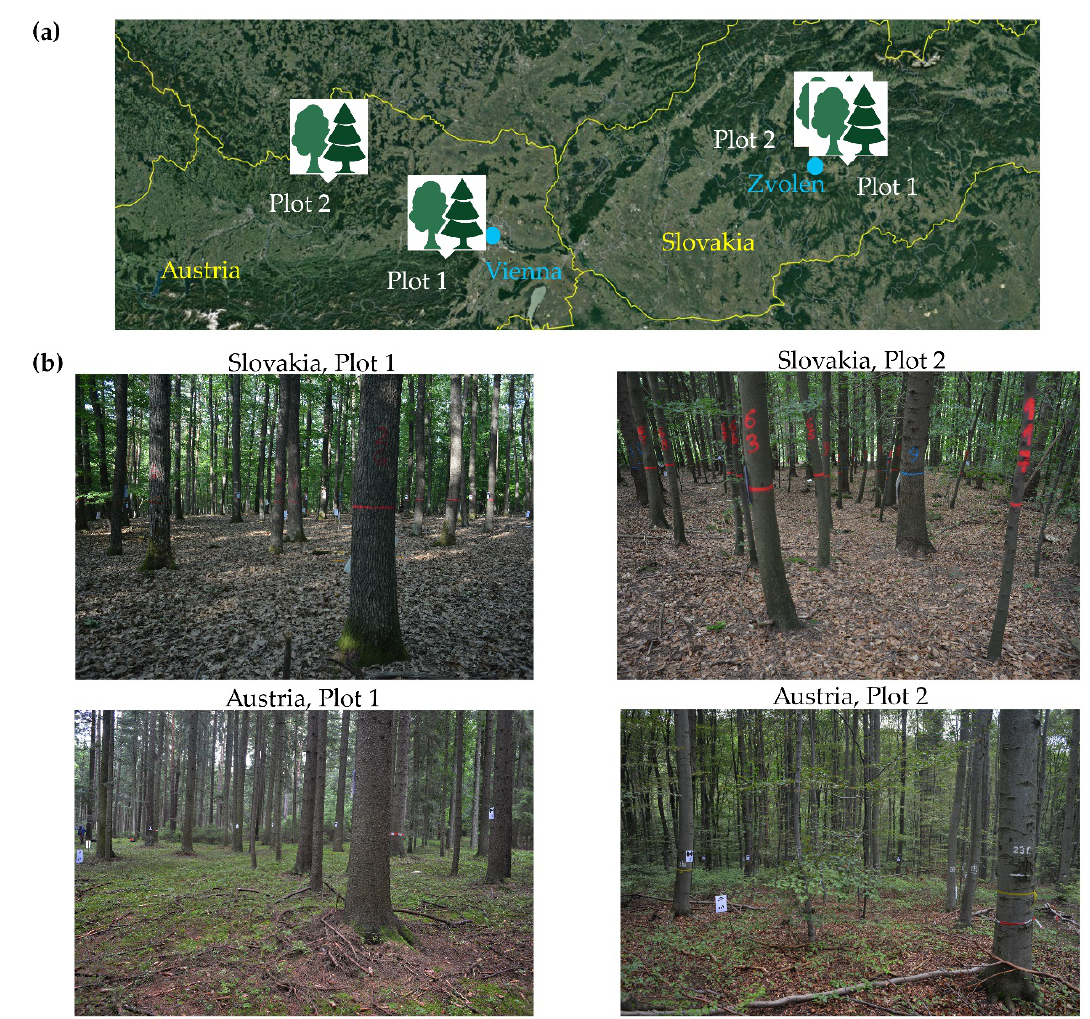
Figure 1. ( a ) Overview of the forest plot locations and ( b ) for each forest plot, a photo illustrating the forest at the time of the survey.